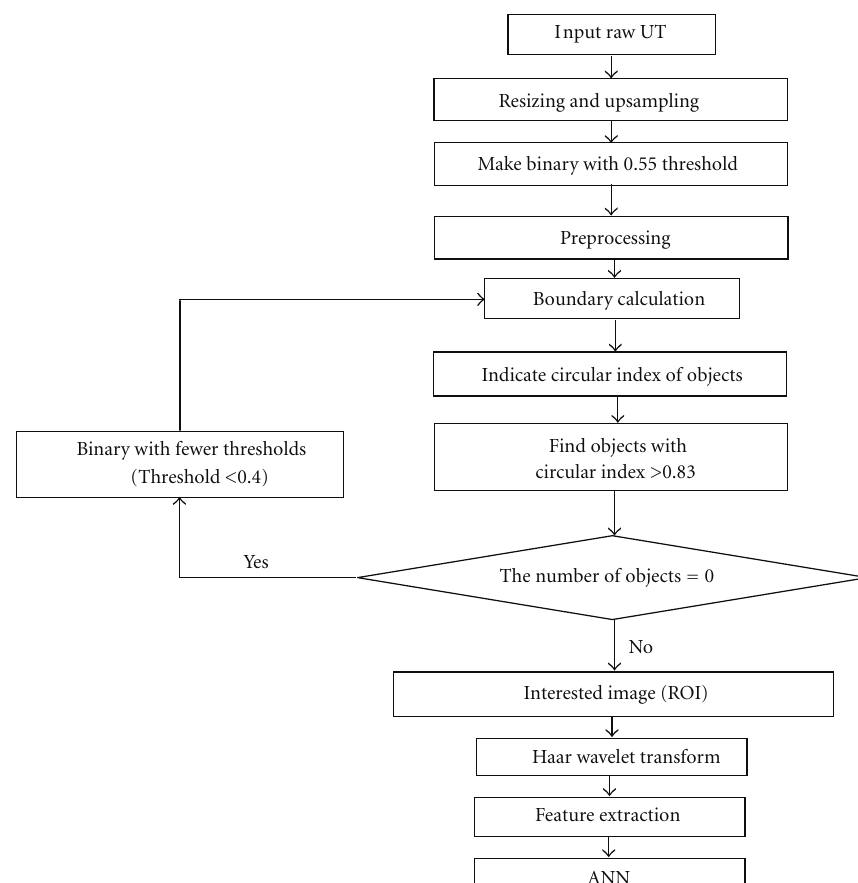
Figure 3: Schematic diagram of proposed